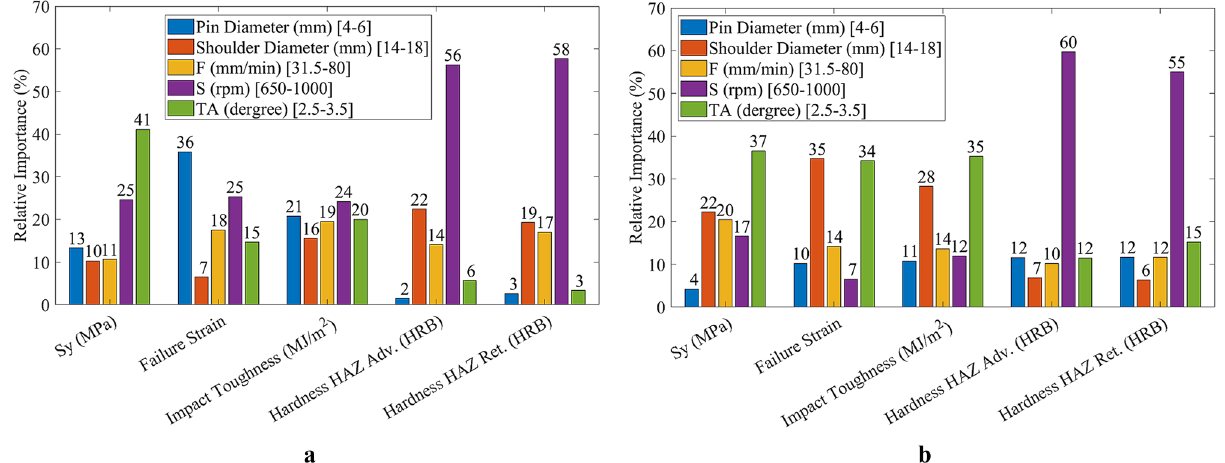
Figure 11. Relative importance of parameters affecting objective functions: ( a ) conical pin, ( b ) threaded cylindrical pin.